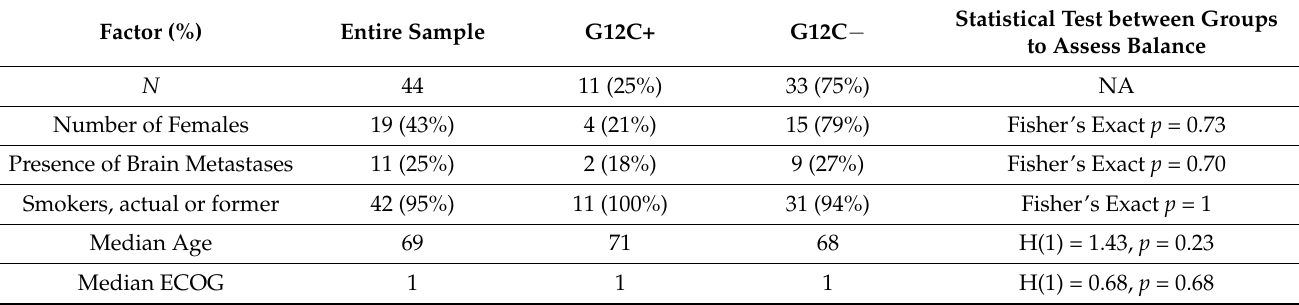
Table 1. Summary of Patient’s Characteristics. Abbreviations: G12C+, cases with a G12C mutation in the KRAS gene; G12C − , cases without a G12C mutation in the KRAS gene; mut, mutation; N , number; NA, not available, p , p value.